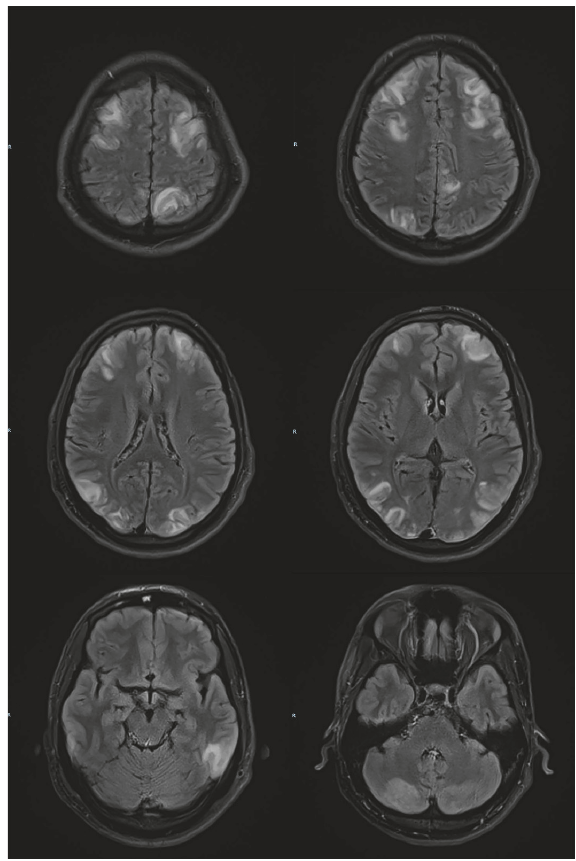
Figure 2: T2 FLAIR sequence. MRI brain done on Day 14 of heat strokeshowednearcompleteresolutionoftheabnormalcorticaland subcortical signal intensity and swelling, compatible with diagnosis of